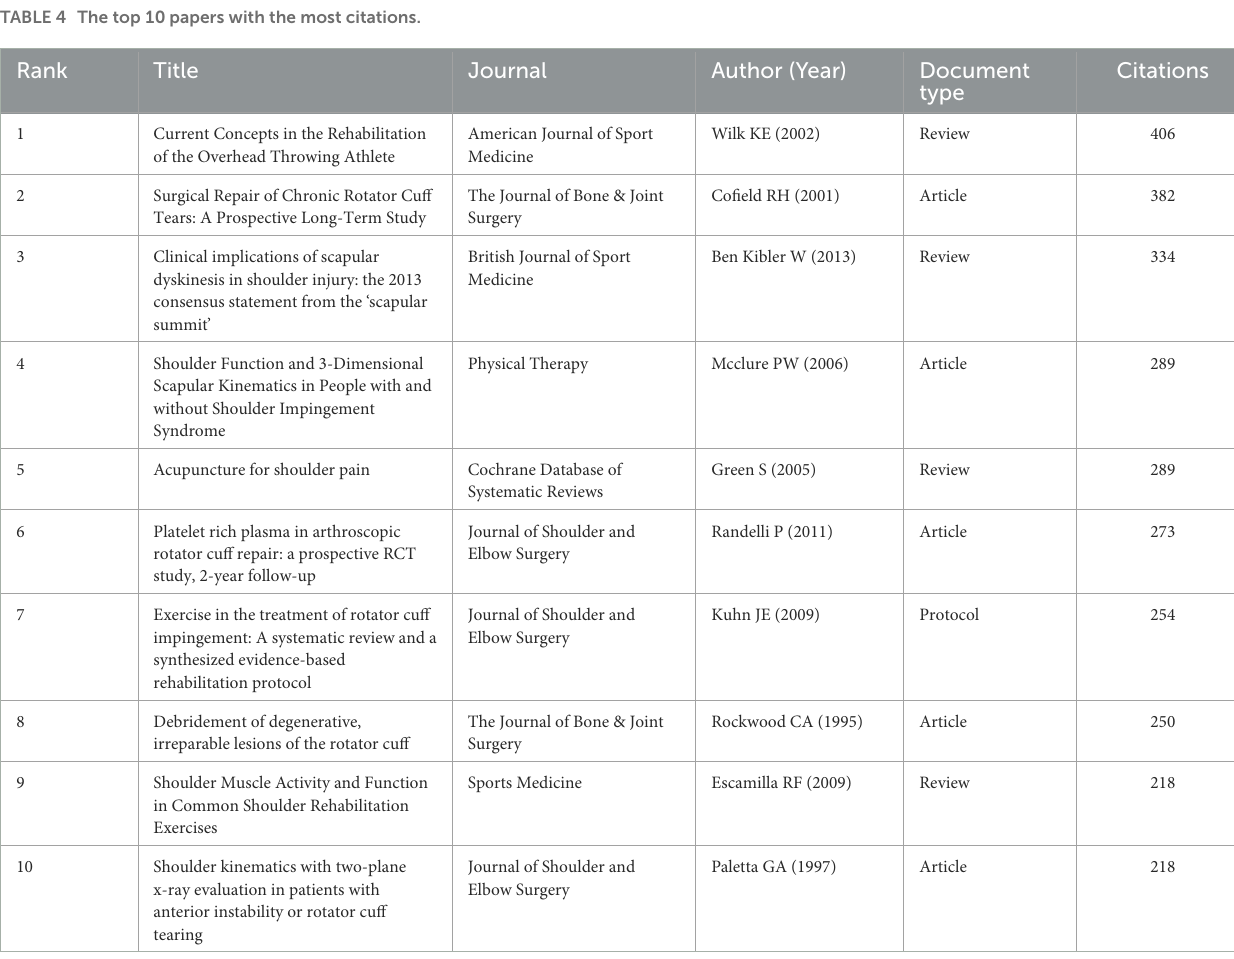
TABLE 4 The top 10 papers with the most